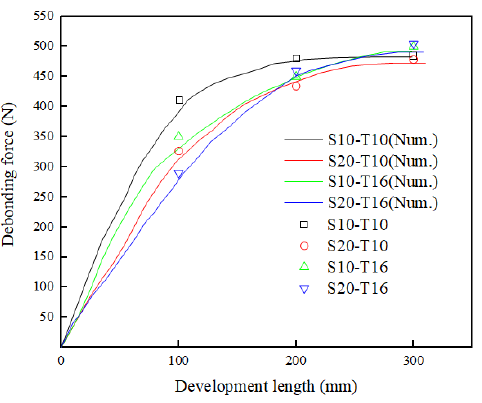
Figure 10. Comparison between experimental data and theoretical debonding force versus development length